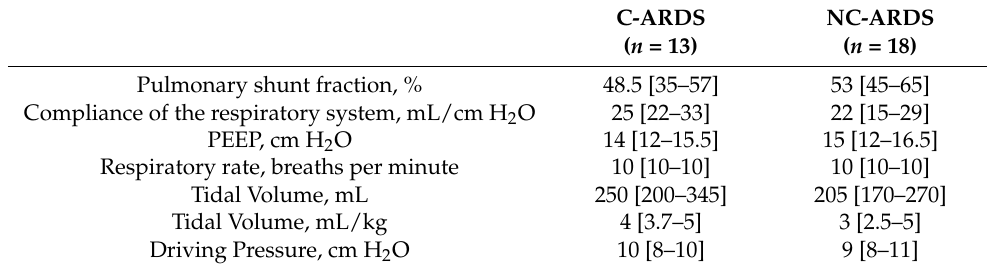
Table 2. Clinical characteristics and ventilation parameters before EIT